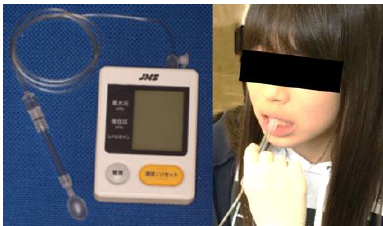
Figure 10. Tongue pressure force measurement. The tongue pressure force was measured using a TPM01 (JMS Co., Ltd., Hiroshima, Japan). The patient sat with the Frankfurt plane parallel to the clinic floor. The balloon was inserted into the mouth, and the patient was instructed to lightly bite down on the hard ring with the upper and lower central incisors, to secure the balloon to the anterior part of the palate.